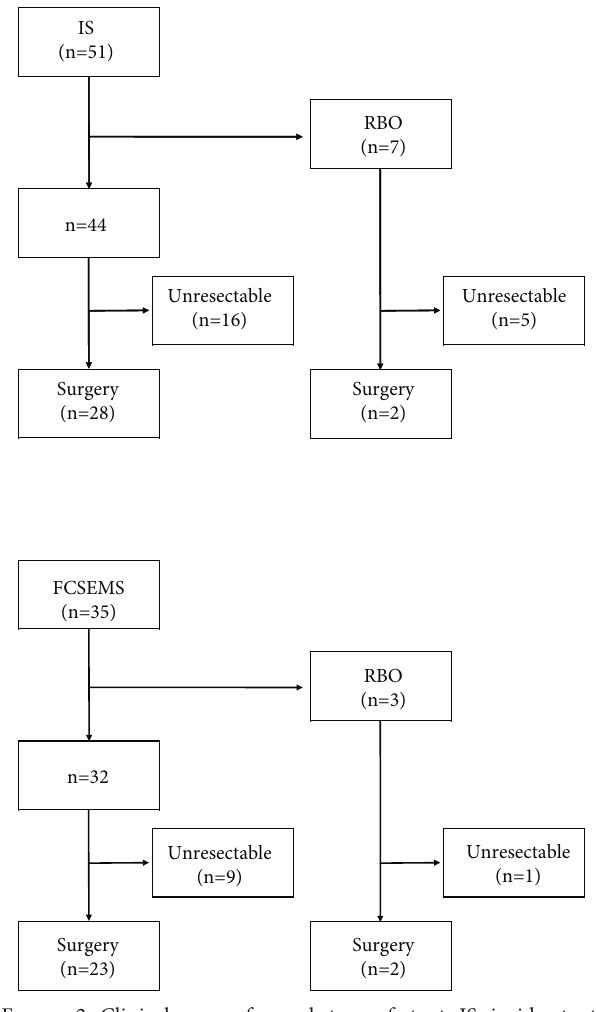
Figure 2: Clinical course for each type of stent. IS, inside stent; FCSEMS, fully covered self-expandable metallic stent; RBO, re- current biliary obstruction.